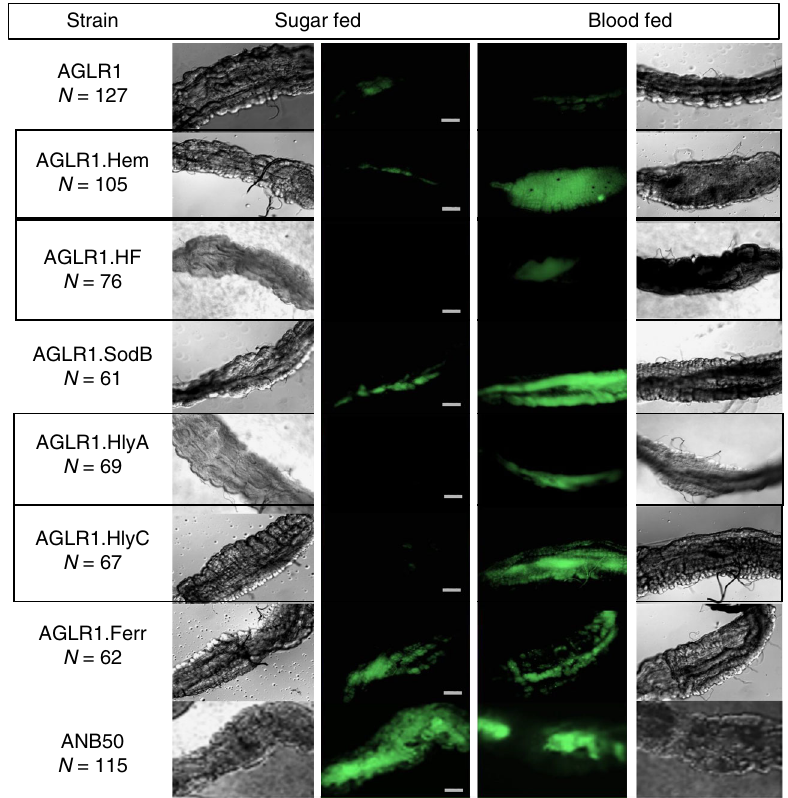
Fig. 2 BMI Asaia strains retain GFP induction in vivo in response to a mosquito blood meal. Bacterial cultures of each strain were fed to mosquitoes and differences in fl uorescence were analyzed by eye between the blood fed and sugar fed individuals of each strain. AGLR1, which contains no promoter, is the negative control and ANB50 is a constitutively fl uorescent positive control. The strains outlined in gray, AGLR1.Hem, HF, HlyA and HlyC, show conditional fl uorescence when exposed to a blood meal vs sugar meal indicating these promoters are induced by the blood meal in the mosquito. Images are representative of all observed midguts and all midguts were observed at the same magni fi cation. The size bars are each 100 µ